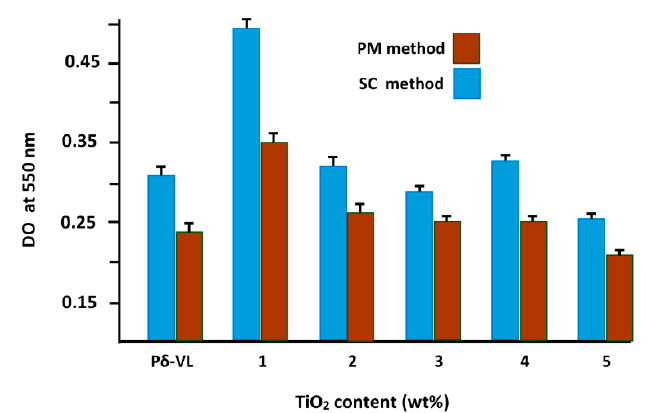
Figure 4. Cell adhesion screening tests performed with virgin P δ -VL and TiO 2 /P δ -VL/TiO 2 hybrid materials with different TiO 2 contents prepared by SC and PM